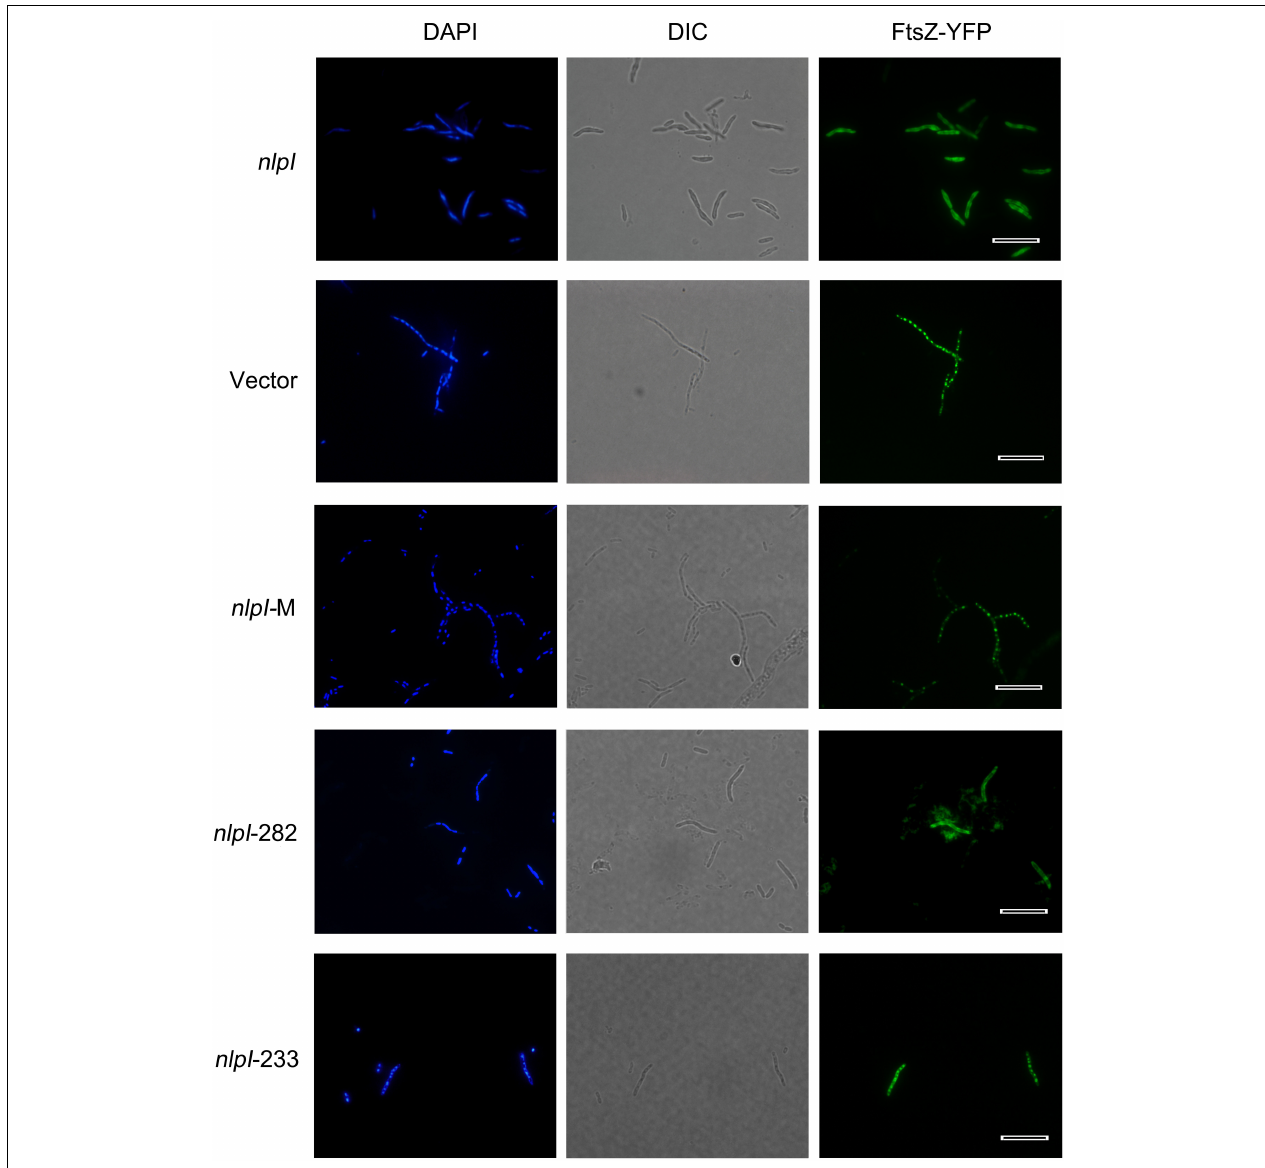
FIGURE 2 | Elevation of nlpI in E. coli disturbed FtsZ localization. Plasmids pQE80- nlpI , pQE80- nlpI -M, pQE80- nlpI -282 and pQE80- nlpI -233 were transformed individually into E. coli strain MC1000 carrying ftsZ-yfp fusion plasmid pWM1410, the resultant